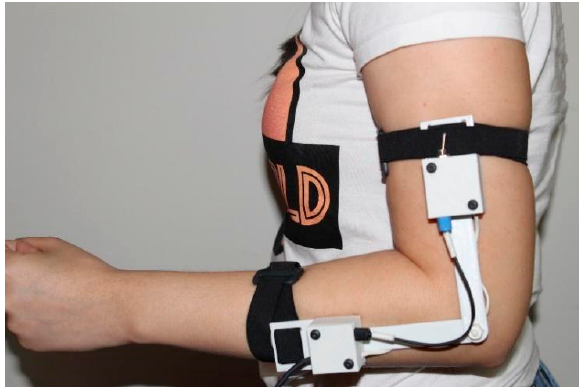
Figure 3. Positioning of the POF sensor at the elbow joint.